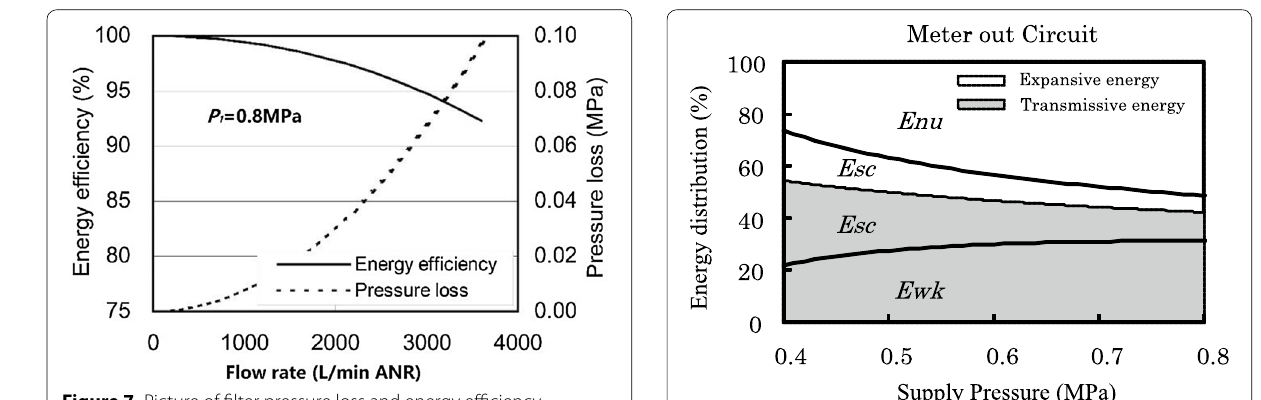
Figure 7 Picture of filter pressure loss and energy efficiency